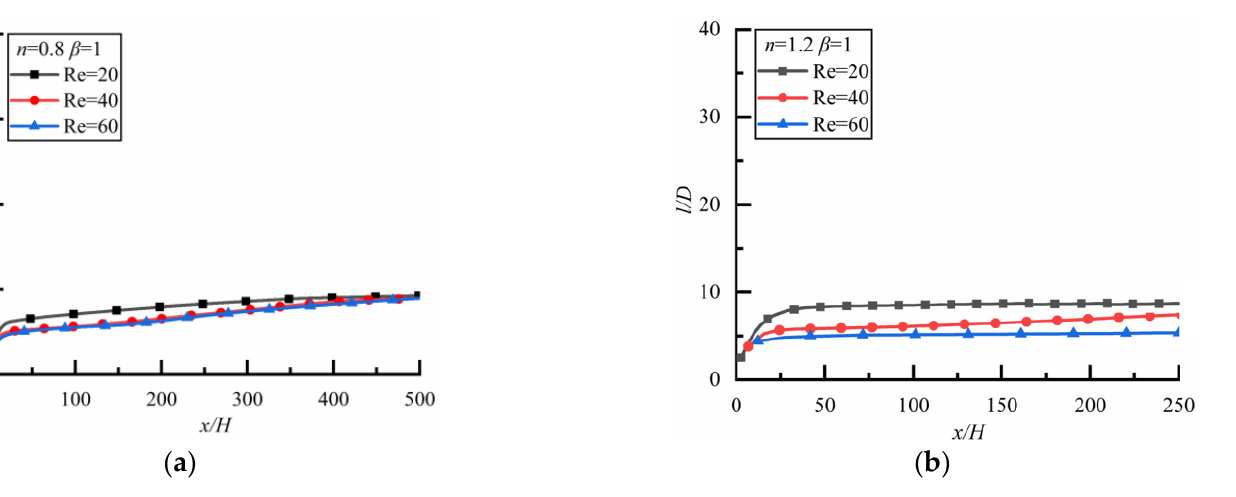
Figure 8. Changes of l/D along flow direction for different Re . ( a ) n =0.8, ( b ) n =1.2.